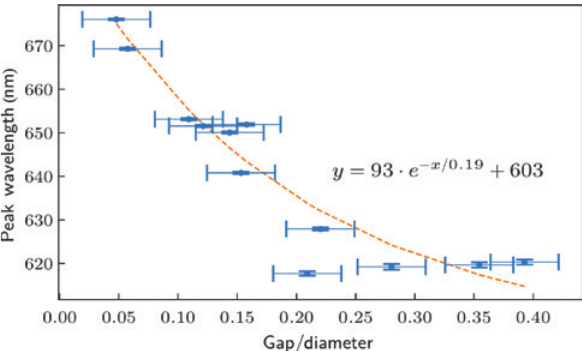
Figure 9: Dependence of the bonding dipolar mode resonant wavelength on the gap width divided by the mean diameter of the spheres for different